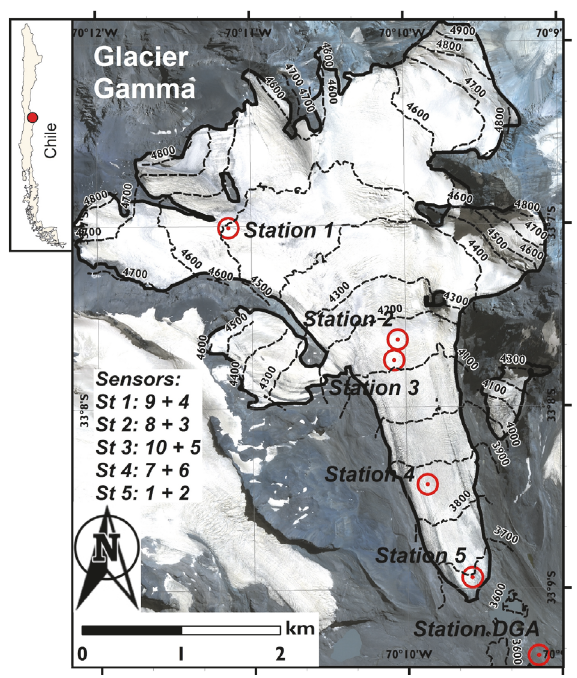
Figure 1: Location of Olivares Gamma Glacier and of meteorolog- ical stations used in the study. Topographic details of stations are giveninTable 1;numbers1–10afterthecolonsrefertoTinytagsensor